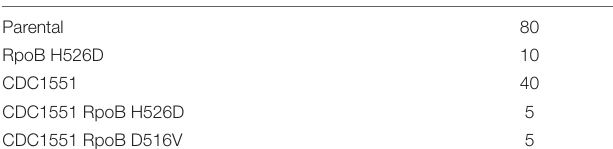
TABLE 1 | Vancomycin minimum inhibitory concentration (MIC) ( µ